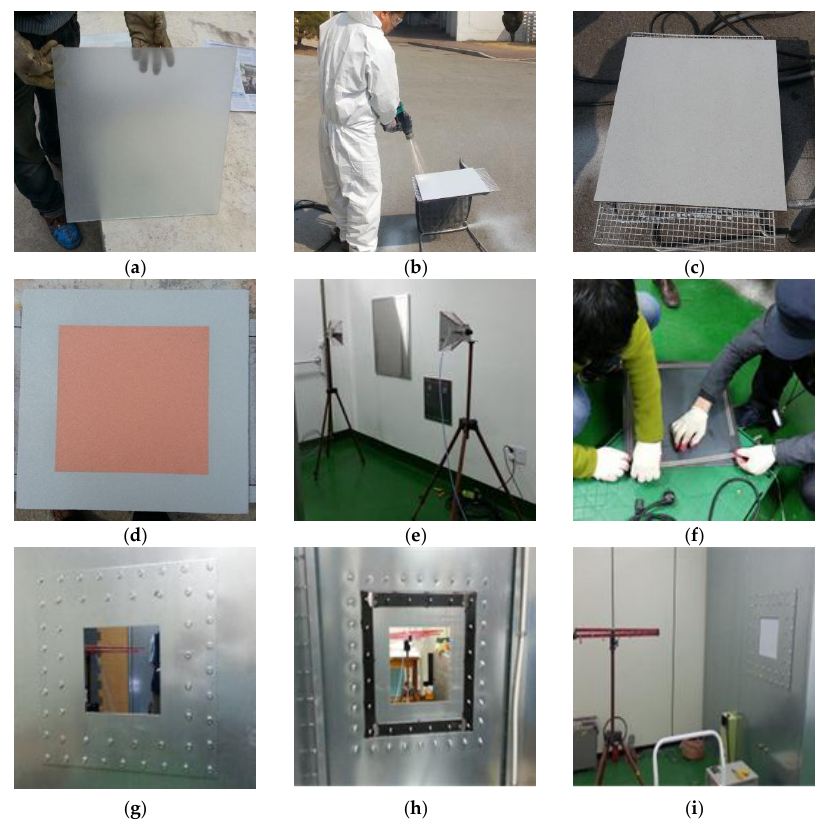
Figure 2e. Finally, the gasket installation, EMP shielding wall outside and inside, and SE test is shown in Figure 2f–i, respectively.